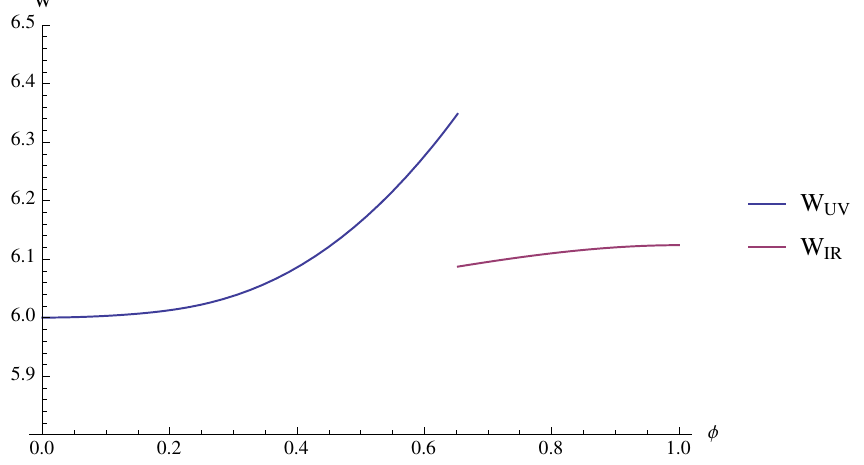
Figure 4 . The superpotential from the UV ( ’ = 0) to the IR ( ’ = 1). The UV-IR matching is at ’ 0 = 0 : 65. On the vertical axis, the superpotential is measured in units of the UV AdS